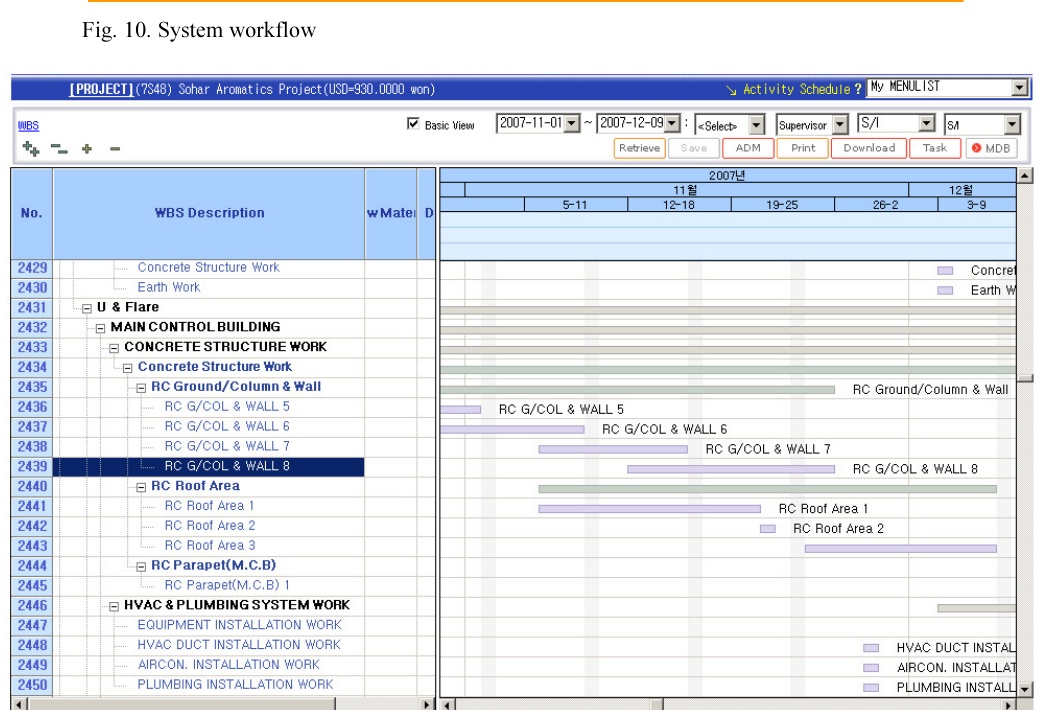
Fig. 11. Detailed activity